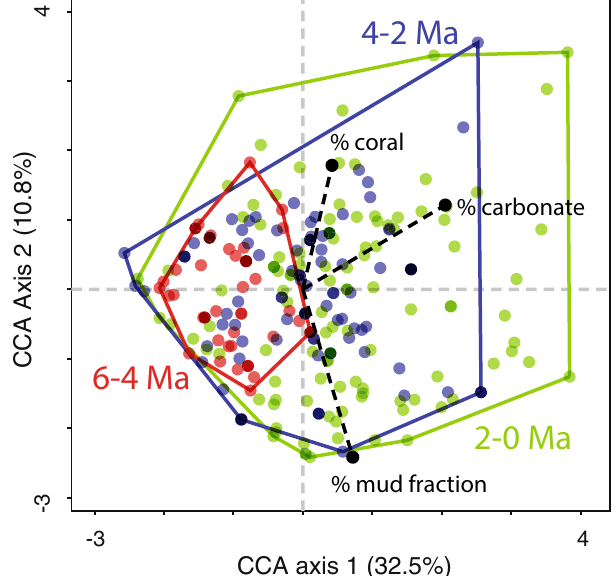
Figure 3. Changes in ecological space of cupuladriid bryozoans over the last 6 Myr in the southwestern Caribbean. Canonical Correspondence Analysis (CCA) 40,85 of sample scores (dots) based on the relative abundances of species of cupuladriid colonies in bulk samples (fossil) and dredges (Recent). The CCA is constrained by the variables % calcium carbonate, % mud and % coral in samples, all of which expanded after ~4 Ma. Samples are grouped into 2 Myr bins.